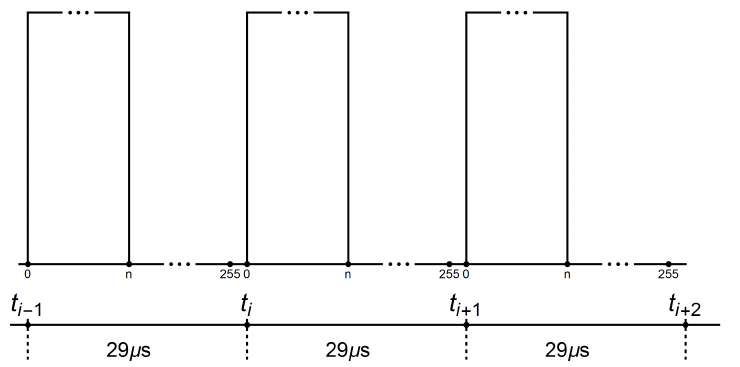
Figure 13. Waveforms of signals controlling the gates of the electronic commutator bridge transistors for the variant with an additional DC/DC converter (figure on the left ), for the variant without an additional DC/DC converter (figure on the right ).